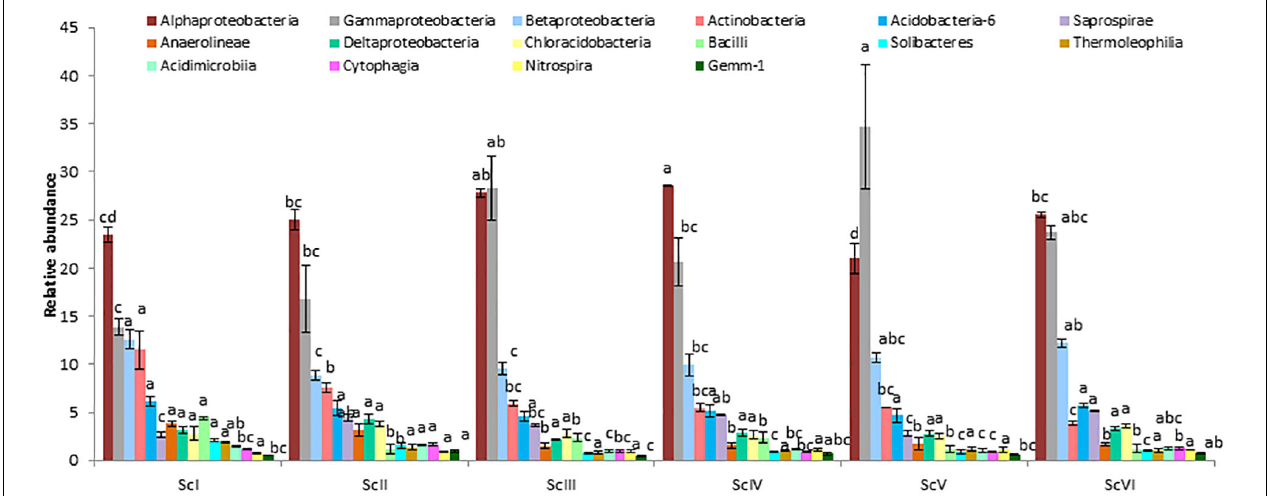
FIGURE 4 | Relative abundance of classes ( > 1%) in different agriculture management scenarios. Where ; ScI, conventional rice-wheat system; ScII, partial CA based rice-wheat-mungbean system; ScIII, partial CSA based rice-wheat-mungbean system; ScIV, partial CSA based maize-wheat-mungbean system; ScV, full CSA based rice-wheat-mungbean system with sub surface drip irrigation; ScVI, full CSA based maize-wheat-mungbean system with sub surface drip irrigation. The same letters within each column are not statistically different ( P ≤ 0.05, Duncan’s multiple range test) and values are the average of three replicates ( n = 3); means ± standard error